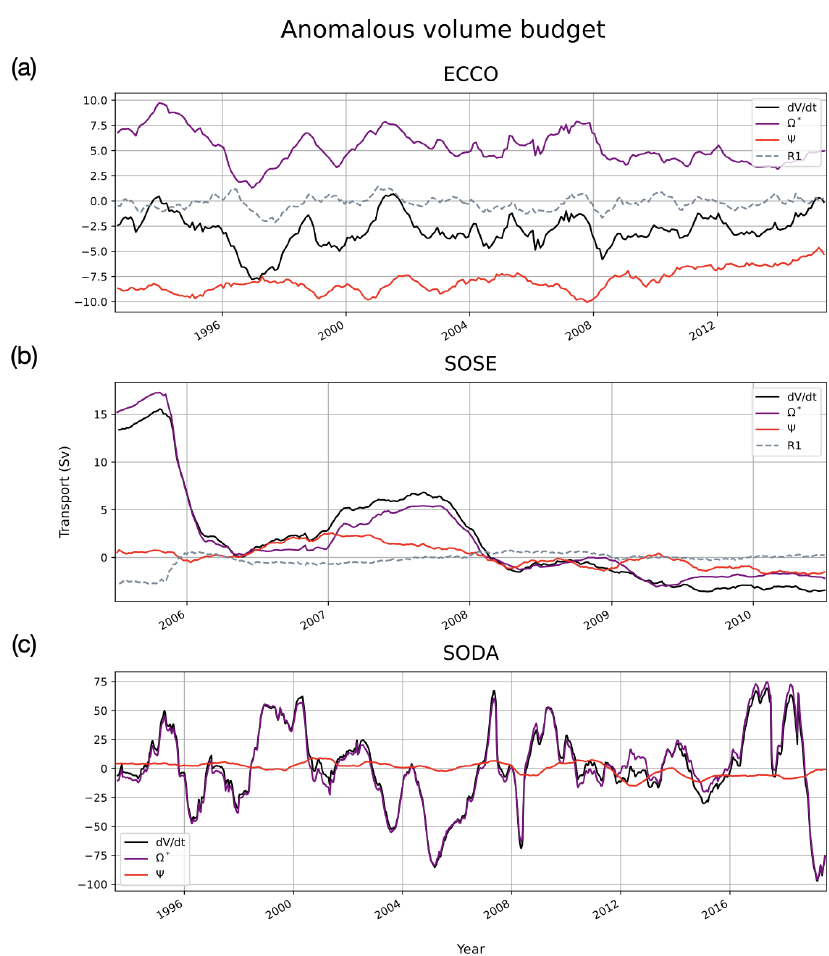
Figure 10. Anomalous main terms of WMT volume budget in ECCO (a) , SOSE (b) and SODA (c) . Time series was smoothed by an annual rolling mean with the center window set to the middle of the year. Volume change is the black line and transport the red line, transformation is the purple line (includes R 2 in ECCO and SOSE, and in SODA it also includes R 1 and R 2), and the discretization residual is explicitly shown as the dashed grey line in ECCO and